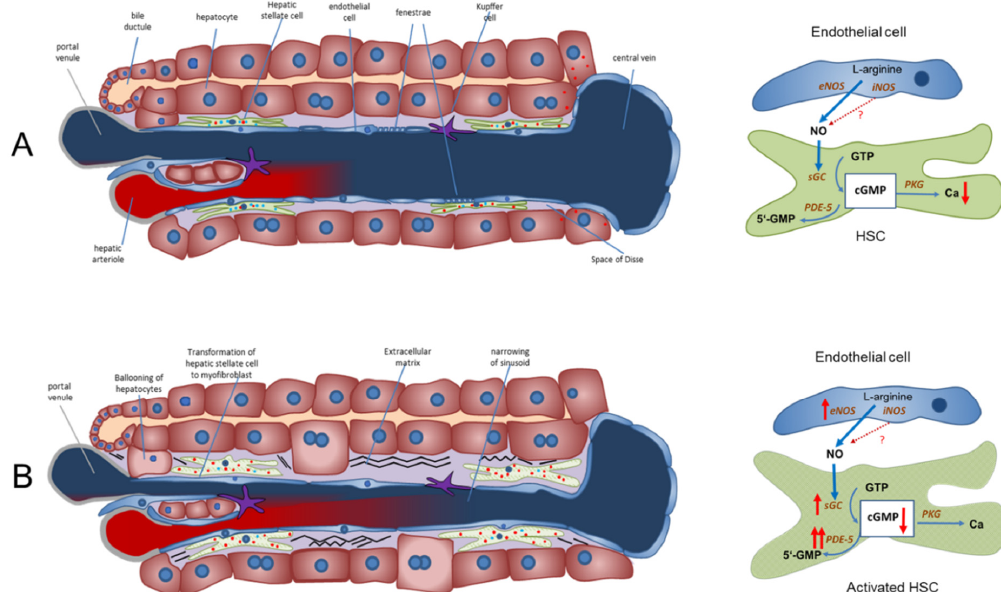
Figure 1. The NO-cGMP pathway as the main regulator of sinusoidal and vascular tone in a healthy and cirrhotic liver (modified from Schaffner et al. (2018) [42] and Kreisel and Schaffner et al. (2020) [33]). ( A ) Regulation of sinusoidal tone in a healthy liver. In a healthy liver, an opposing zonation of sGC and PDE-5 may lead to high cGMP production in the peripheral parts of the hepatic lobule (high sGC), in which cGMP may exert its physiological function inside the sinusoids. Excess